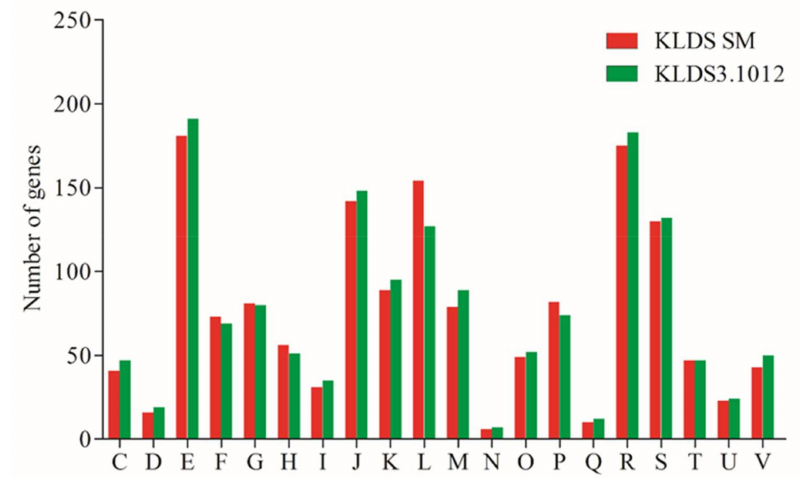
Figure 3. COG functional classification of protein-coding gene in S. thermophilus KLDS SM and S. thermophilus KDLS3.1012 genome. C: Energy production and conversion; D: Cell cycle control, cell division, chromosome partitioning; E: Amino acid transport and metabolism; F: Nucleotide transport and metabolism; G: Carbohydrate transport and metabolism; H: Coenzyme transport